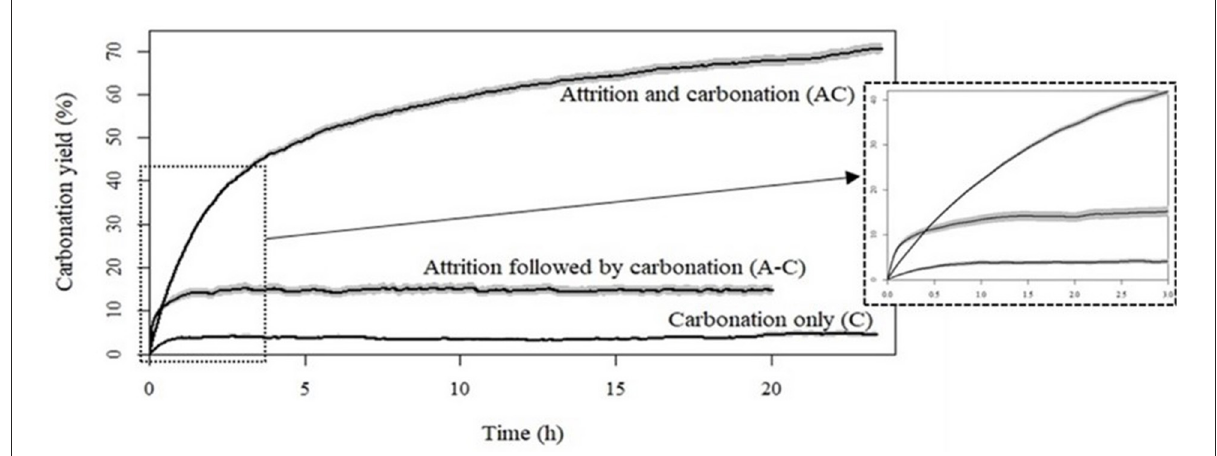
FIGURE4 Time variation of carbonation yield for ferronickel slags carbonated under C, A-C, and AC modes.